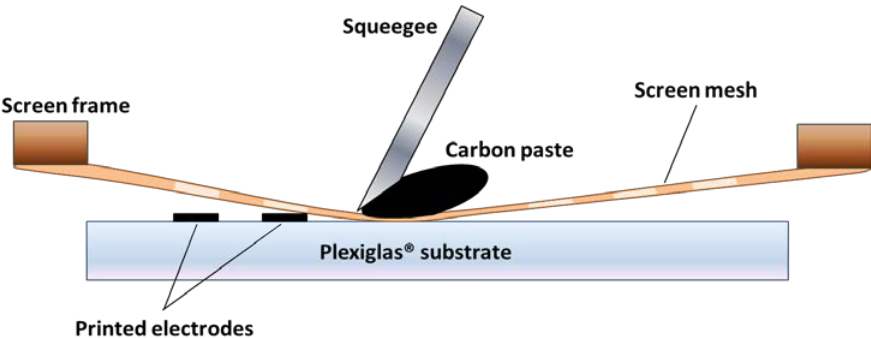
Figure 1. Sketch of the basic screen-printing procedure. The squeegee moves from the left to the right edge of the substrate, forming an angle of about 60° with the substrate surface.